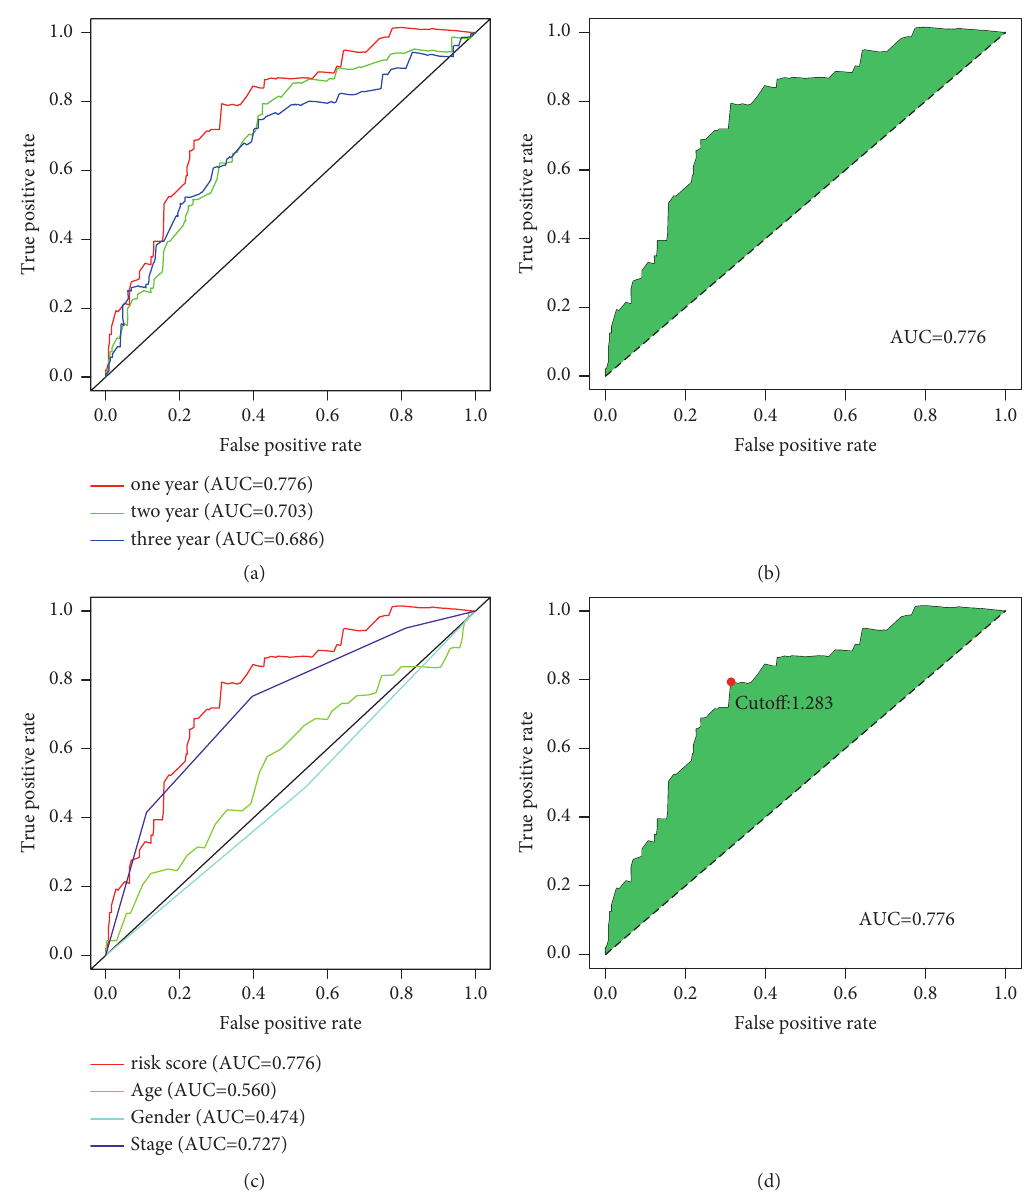
Figure 4: The prediction performance of the receiver operating characteristic (ROC) curves for the model signature. (a) ROC curves show 1- year/2-year/3-year curves and AUC. (b) ROC curve with the optimal AUC value within three years. (c) ROC curves for the comparison of clinical characteristics and signature. (d) The optimal cutoff point plots generated by